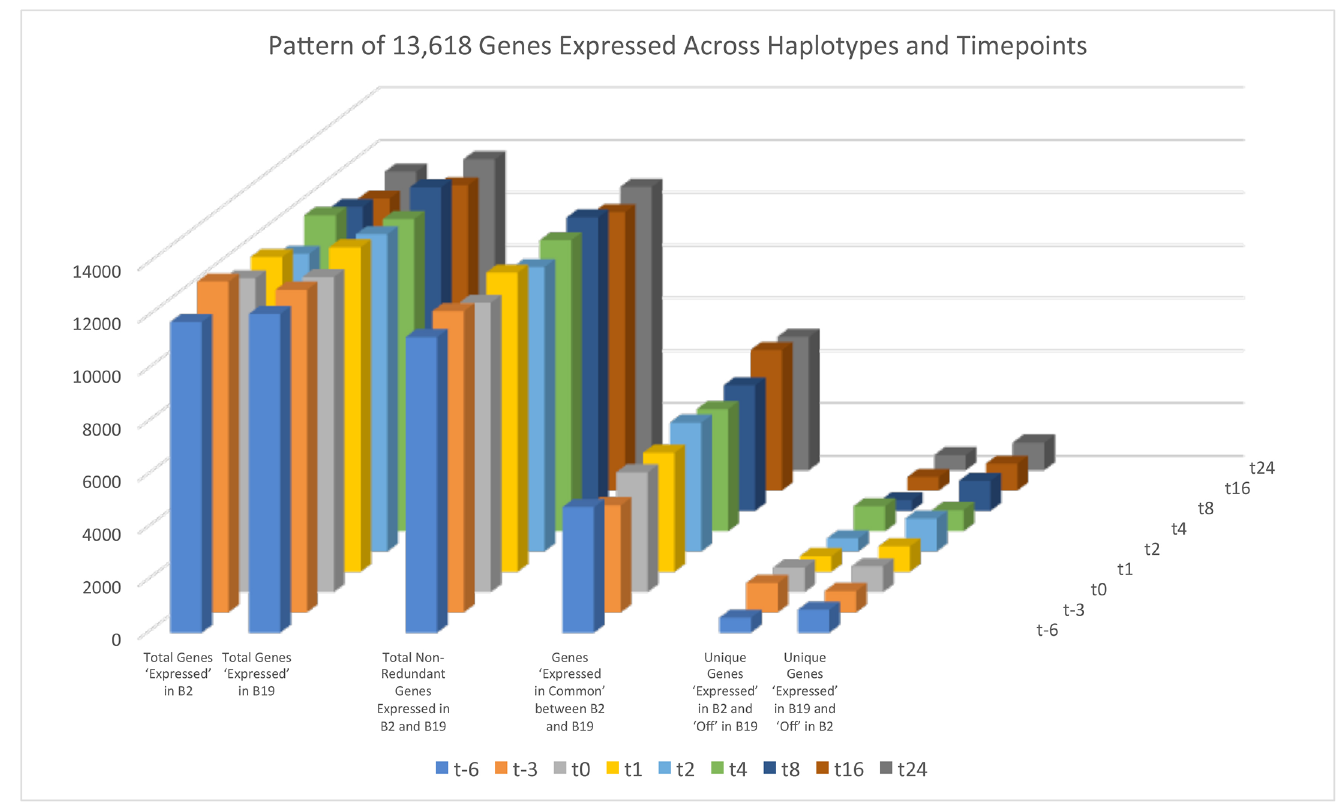
Fig 1. Pattern of 13,618 genes expressedacross haplotypes and timepoints. Visualrepresentation of geneswithin B2 and B19 haplotypes at each of the time points. Figure includesgenes expressedin common, genes expressedonly in B2, genes expressedonly in B19, all genes expressedin B2, all genesexpressedin B19, and total non-redundant genes expressedin either B2 or B19 haplotypes.